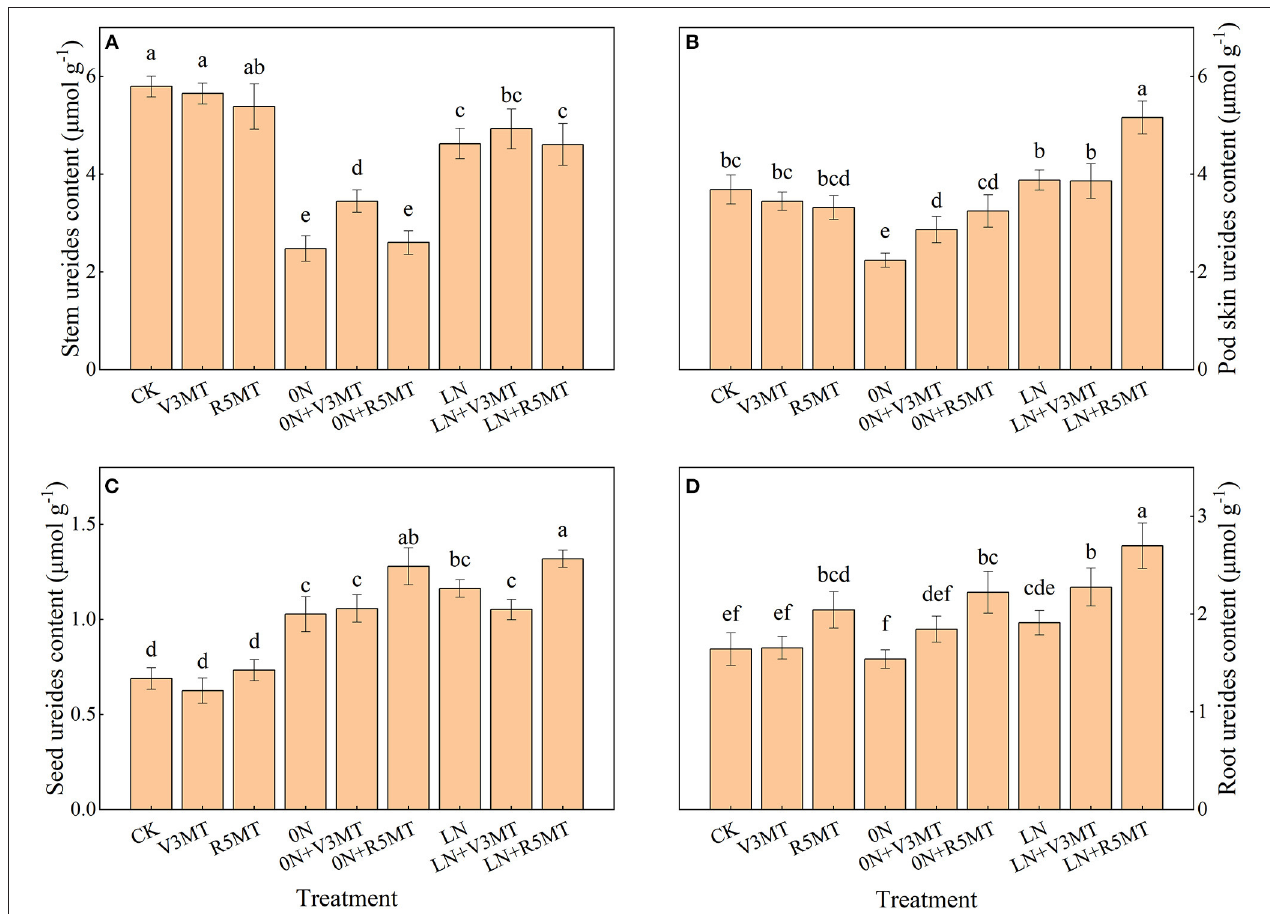
FIGURE 7 | The effect of exogenous melatonin (V3 and R5) on ureide content of stem (A) , pod skin (B) , seed (C) , and root (D) under three N levels. The abbreviated meaning of each treatment is the same as in Figure 3 . The values were presented as mean ± SE ( n = 3). Different letters in one measuring group indicate statistically significant differences when P ≤